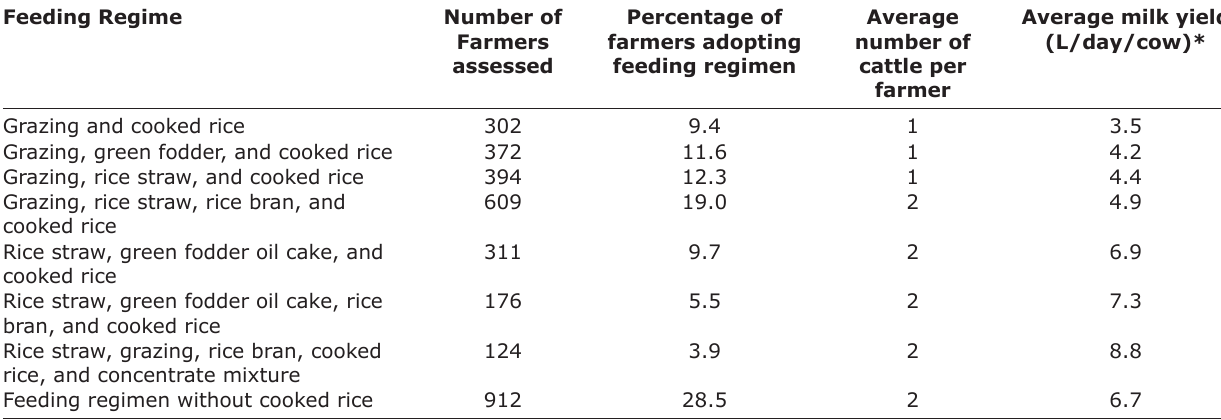
Table-1: Feeding regimen, farm holding, and milk yield of cross-bred dairy cattle maintained by unorganized dairy farmers of Tamil Nadu, India. Feeding Regime